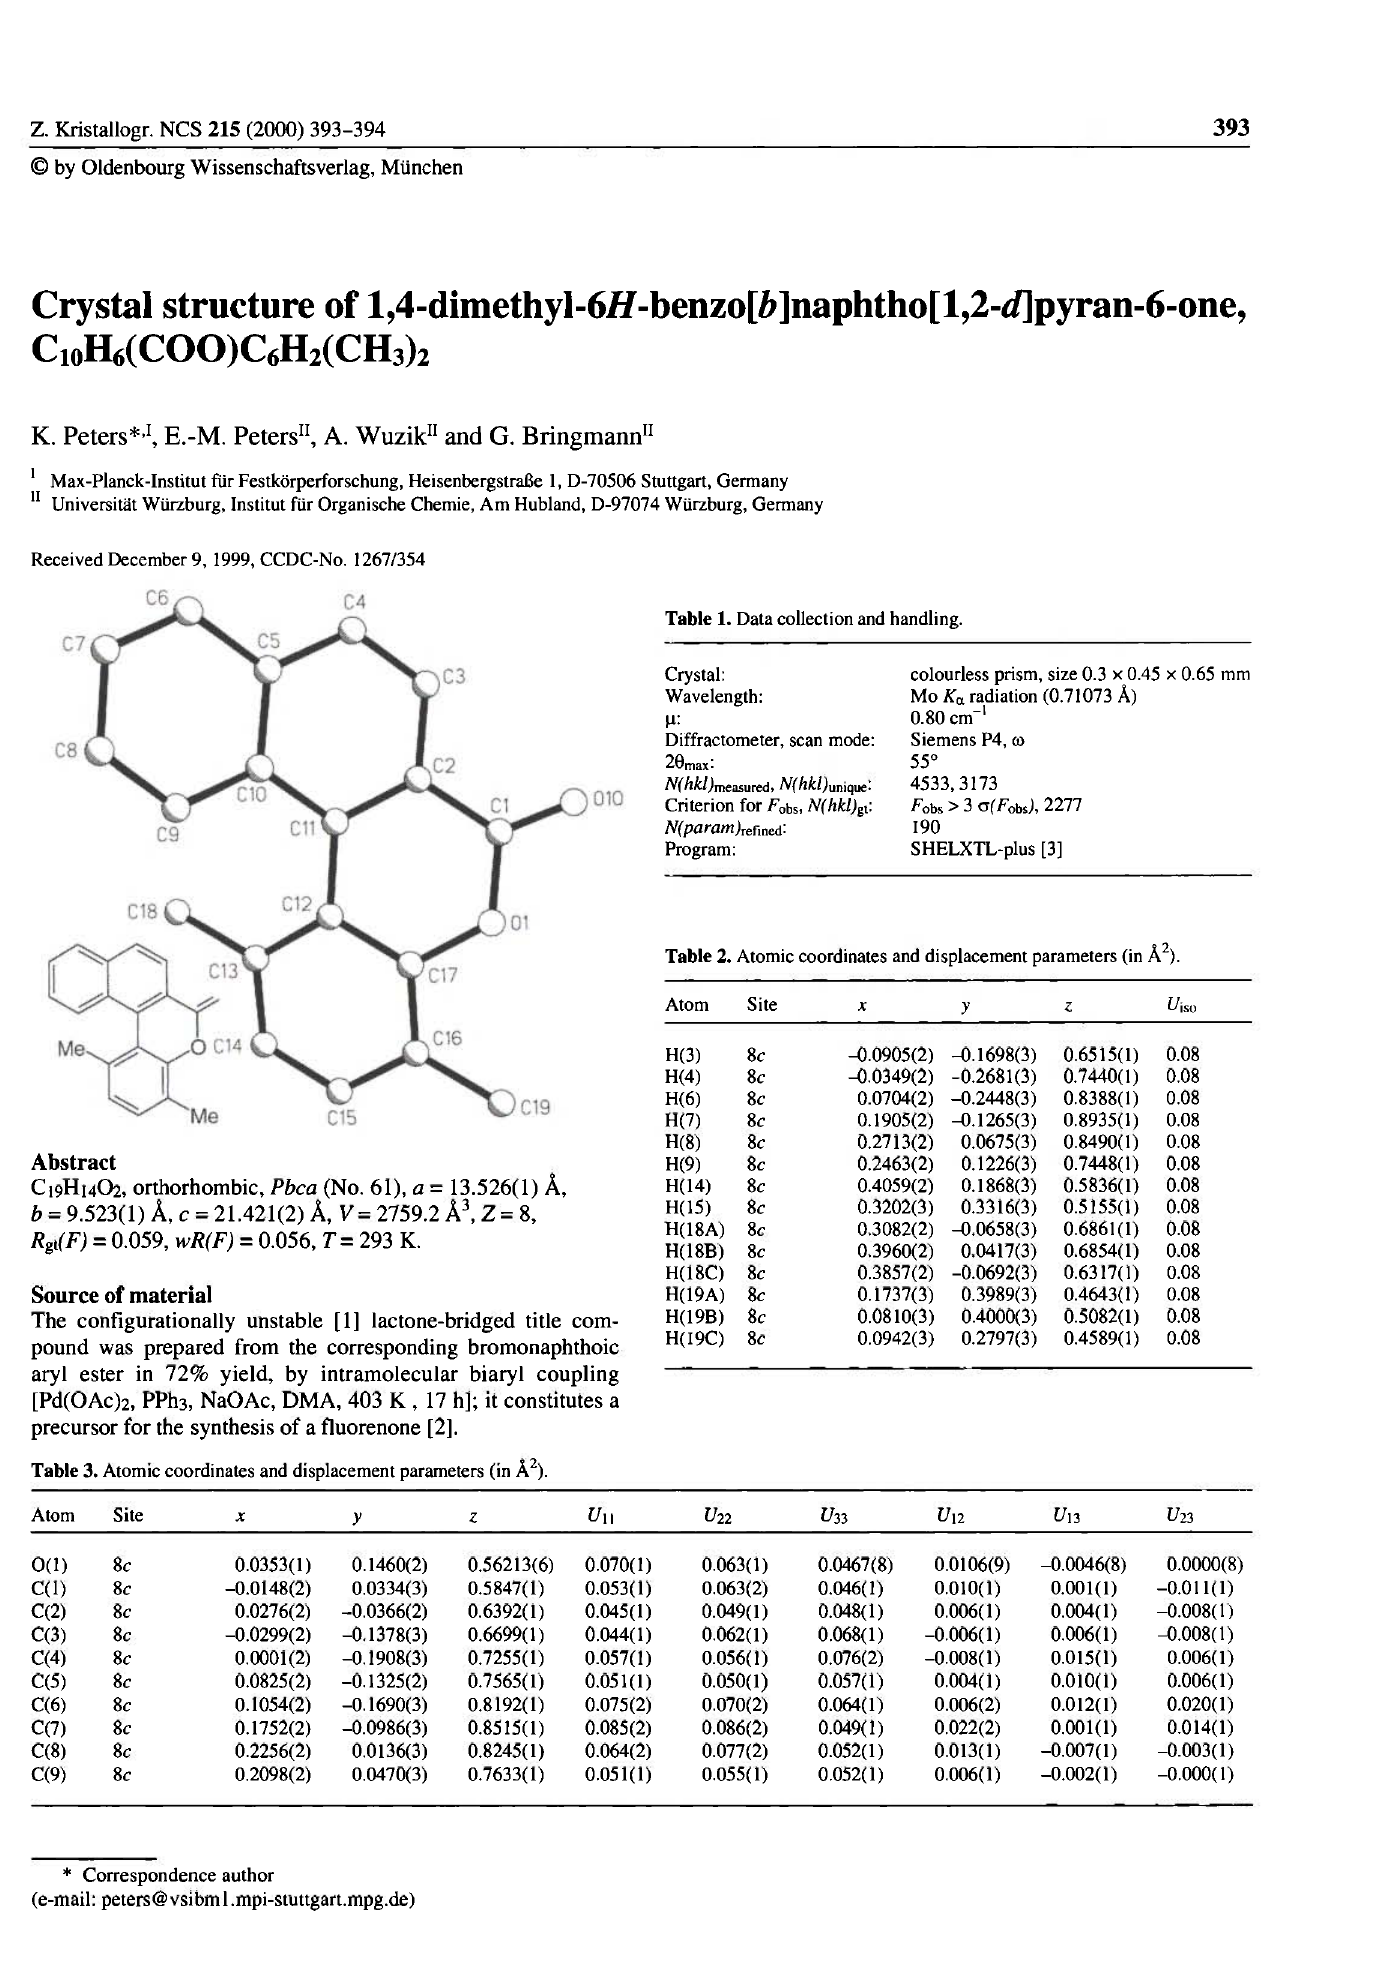
Table 3. Atomic coordinates and displacement parameters (in A 2 ).